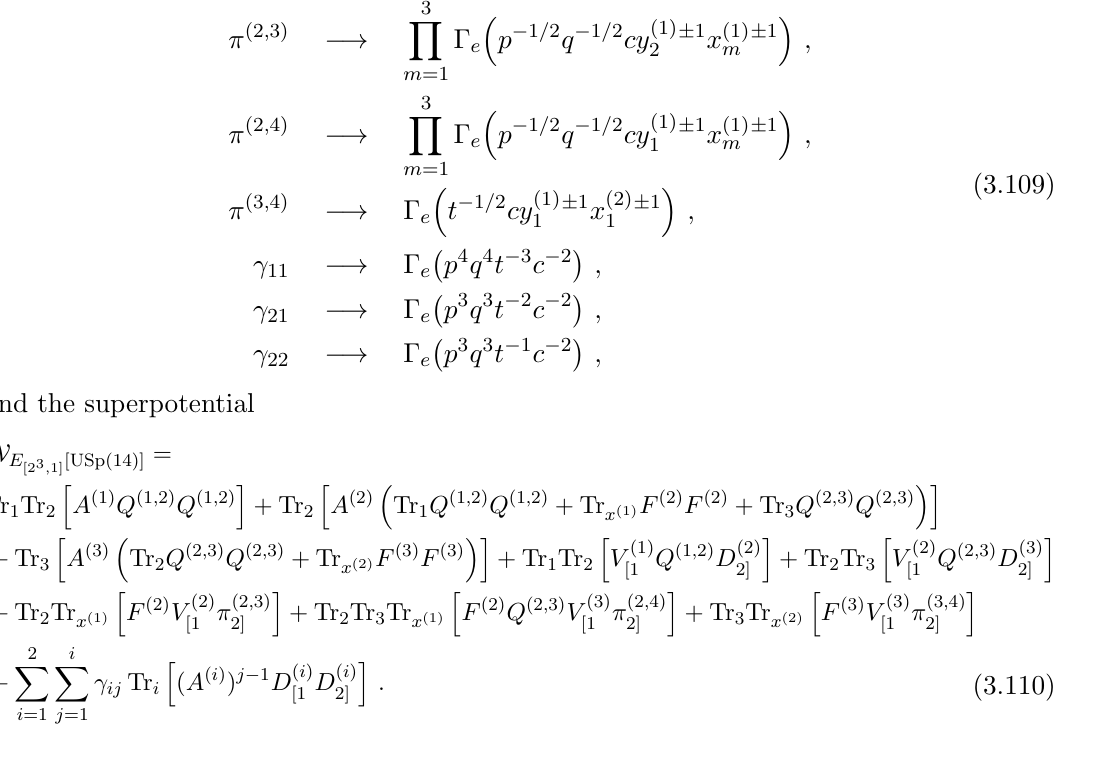
3 ; 1] [USp(14)]. Three (cid:13)ipping (cid:12)elds (cid:13) 11 ; (cid:13) 21 and [2 3 ; 1] D (1) ; Tr 2 D (2) D (2) and Tr 2 A (2) D (2) [1 2] [1 2]